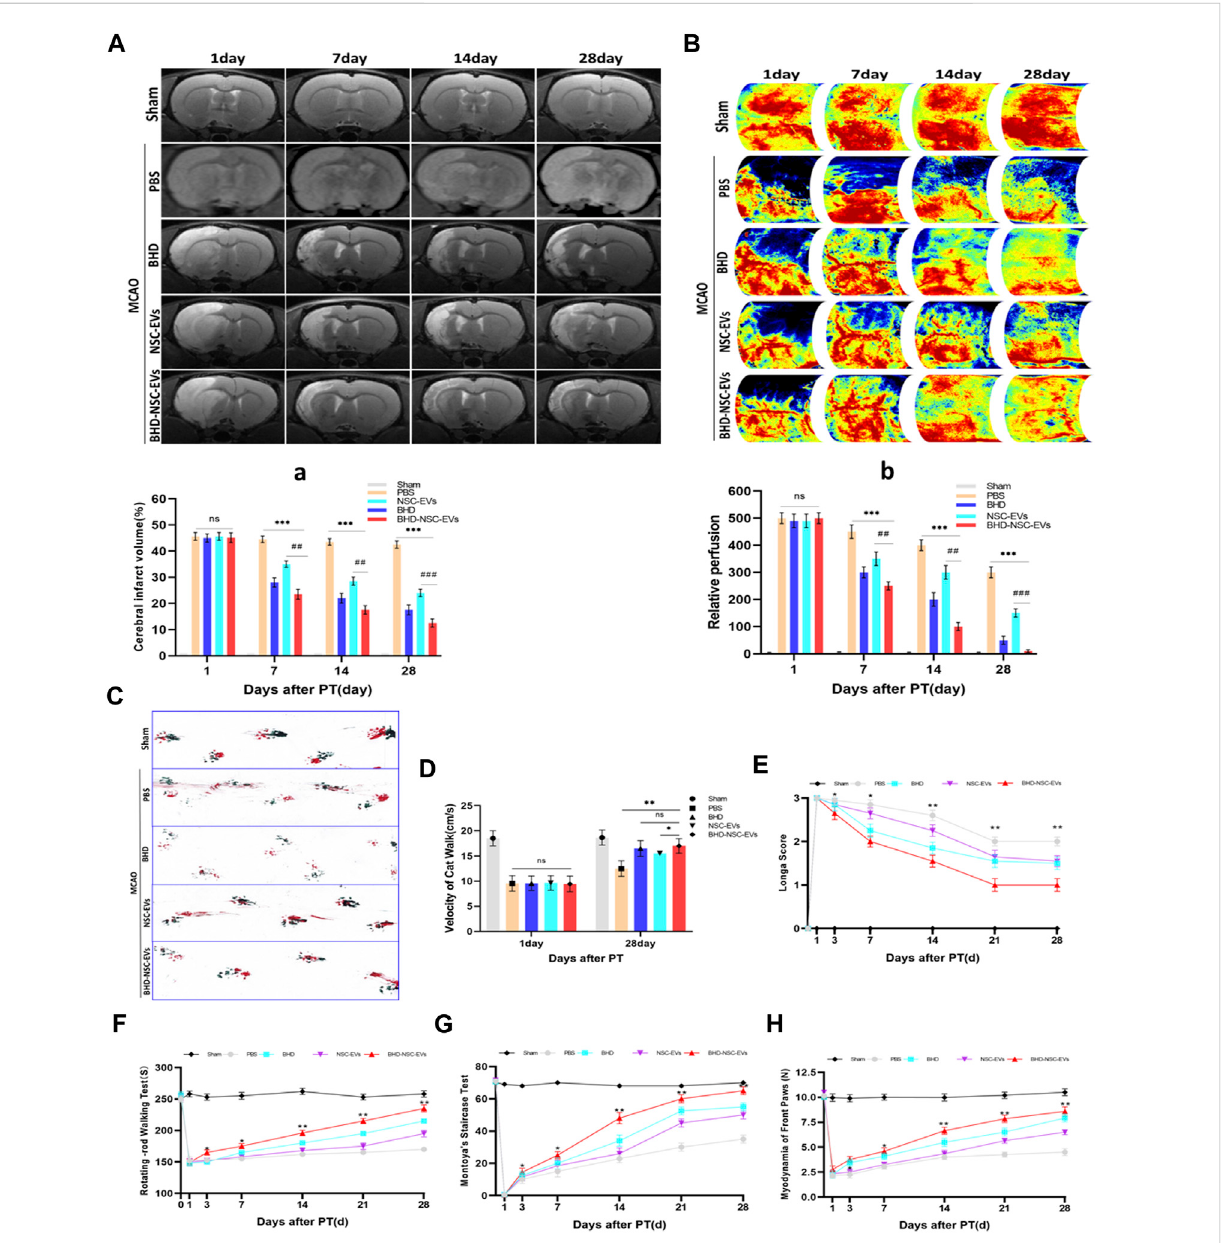
FIGURE 4 The therapeutic effect of BHD-NSC-EVs on the acquired neurological impairment after ischemic stroke. (A-a) T2-weighted images (T2WI) of MRI revealed the changed infarct volume of brain ischemia rats after MCAO and treatment at different test period, the ischemic lesion shown in white using ImageJinBHD-NSC-EVsgroupreducedmoreobviousthanthatinothergroups.( n =7/group),ns:nosigni fi cance. ## p < 0.01, ### p < 0.001,*** p < 0.001. (B-b) Representative images of Laser speckle of cerebral blood fl ow showed the changed cerebral vascular perfusion after MCAO and treatment at different test period. BHD-NSC-EVs signi fi cantly promoted cerebral vascular perfusion recovery relative to other treatments. n = 7 rats/group, ns: no signi fi cant. ( n = 7/group), ns: no signi fi cance. ## p < 0.01, ### p < 0.001, *** p < 0.001. (C,D) Gait analysis after MCAO and treatment or not. (C) Representative footprintsofratswalking 28 days, blueandred represent frontpaw andhindpawprints, respectively, drag marksindicatedlack ofwalking coordination. (D) velocity of cat walk test revealed signi fi cantly faster gait recovery after treatment of BHD-NSC-EVs than others. ( n = 7/group), ns: no signi fi cant. * p < 0.05, ** p < 0.01. (E) Longa score was assessed to evaluate neurological de fi cits after MCAO and treatment or not. ( n = 7) * p < 0.05, ** p < 0.01 BHD-NSC-EVs vs. PBS (F) Rotating-rod walking test evaluated fatigue resistance of motor function after MCAO and treatment or not. ( n = 7/group), * p < 0.05, ** p < 0.01 BHD-NSC-EVs group vs. PBS group (G,H) Front paws myodynamia of rats after MCAO and treatment or not were detected by montoya ’ s staircase test and myodynamia of frontpaws, BHD-NSC-EVs markedly strengthened the myodynamia of front paws after MCAO relative to other treatments. ( n = 7/group), * p < 0.05, ** p < 0.01 BHD-NSC-EVs group vs. PBS group. All data are from three independent experiments and are presented as mean ± s.e.m, two-sided Student ’ s t -tests were used for comparisons , (a,b,D-H)